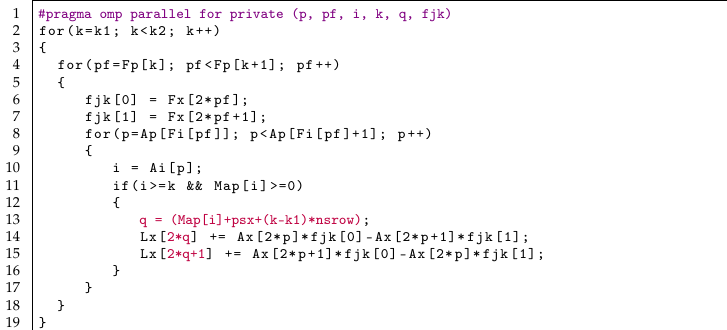
1 #pragma omp parallel for private (p, pf, i, k, q, fjk) 2 for(k=k1; k<k2; k++)